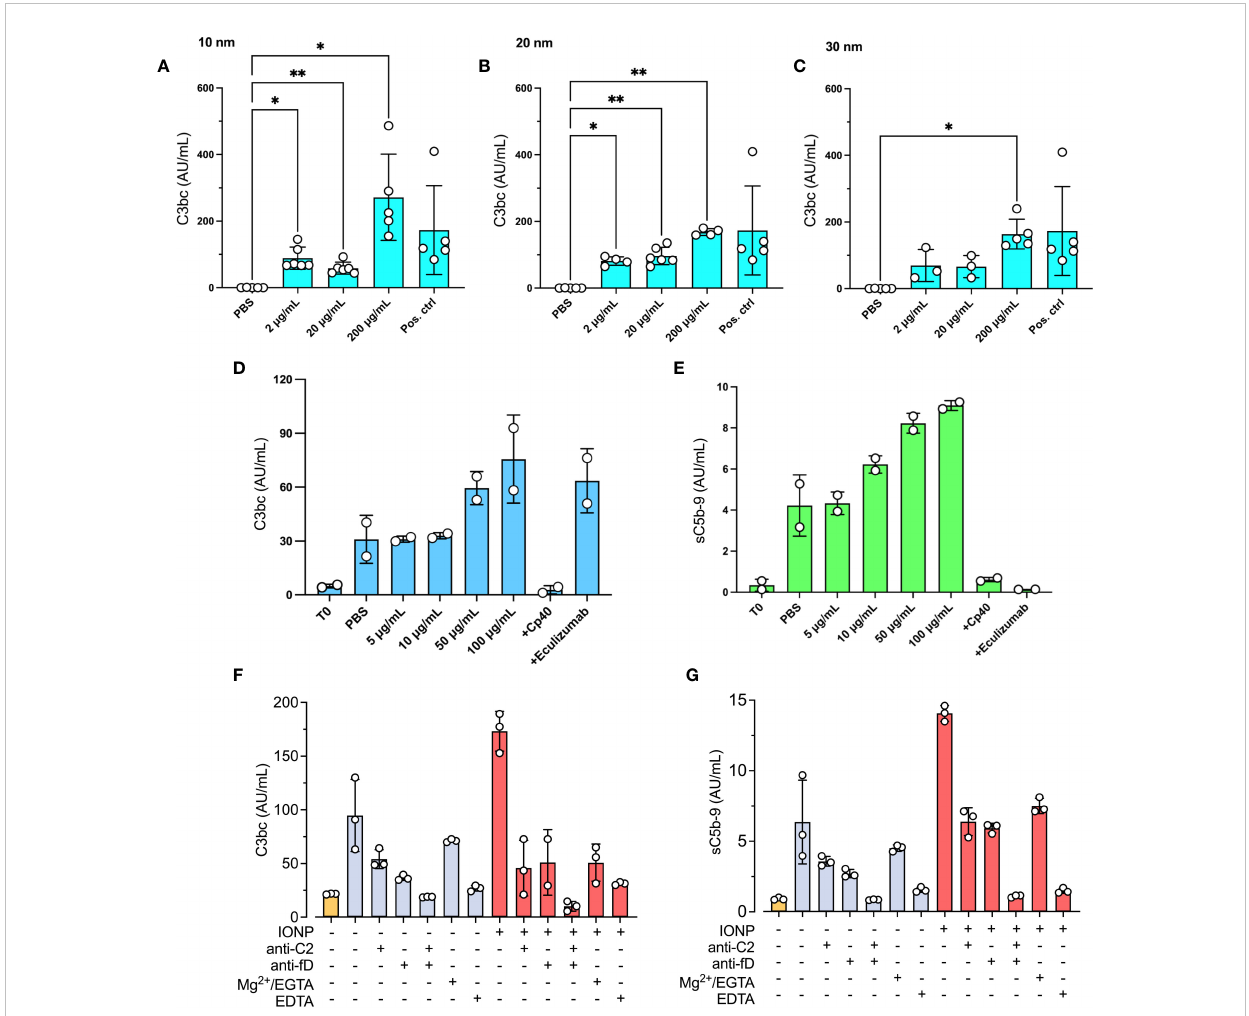
FIGURE 1 IONPs-induced complement activation in plasma. A pool of NHP was incubated with IONPs of various sizes; (A) 10 nm, (B) 20 nm, and (C) 30 nm in increasing concentrations; 2, 20, and 200 m g/mL. PBS was included as a negative control (PBS), and zymosan (100 m g/mL) as the positive control (Pos. ctrl). Complement activation was analyzed by measuring C3bc (A – C) . Separately, a mixture of IONPs containing all different sizes; 10, 20, and 30 nm (IONPs) in concentrations from 0-100 m g/mL, was incubated with NHP in the presence of Cp40 (20 m M) or eculizumab (100 m g/mL).